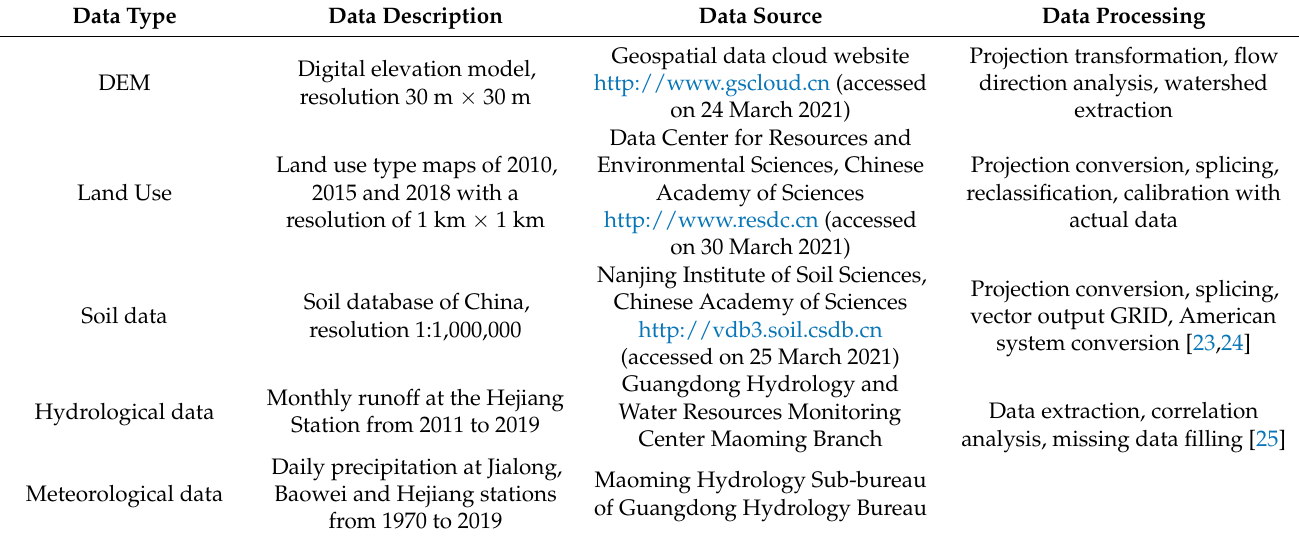
Table 1. Data description and